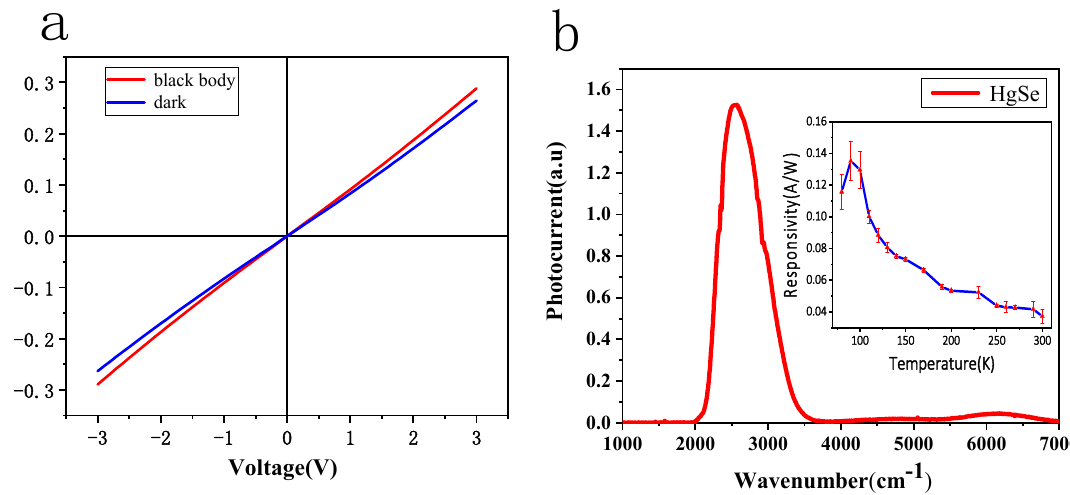
Figure 3. Photocurrent on HgSe CQDs. ( a ) HgSe CQDs as a function of current and voltage at 80 K. The red line represents the photocurrent when photodetector is illuminated by blackbody, and the blue line represents the dark current. ( b ) Photocurrent spectra with HgSe CQDs films at 80 K. The right inset graph shows the responsivity of HgSe CQDs thin films as a function of temperature.